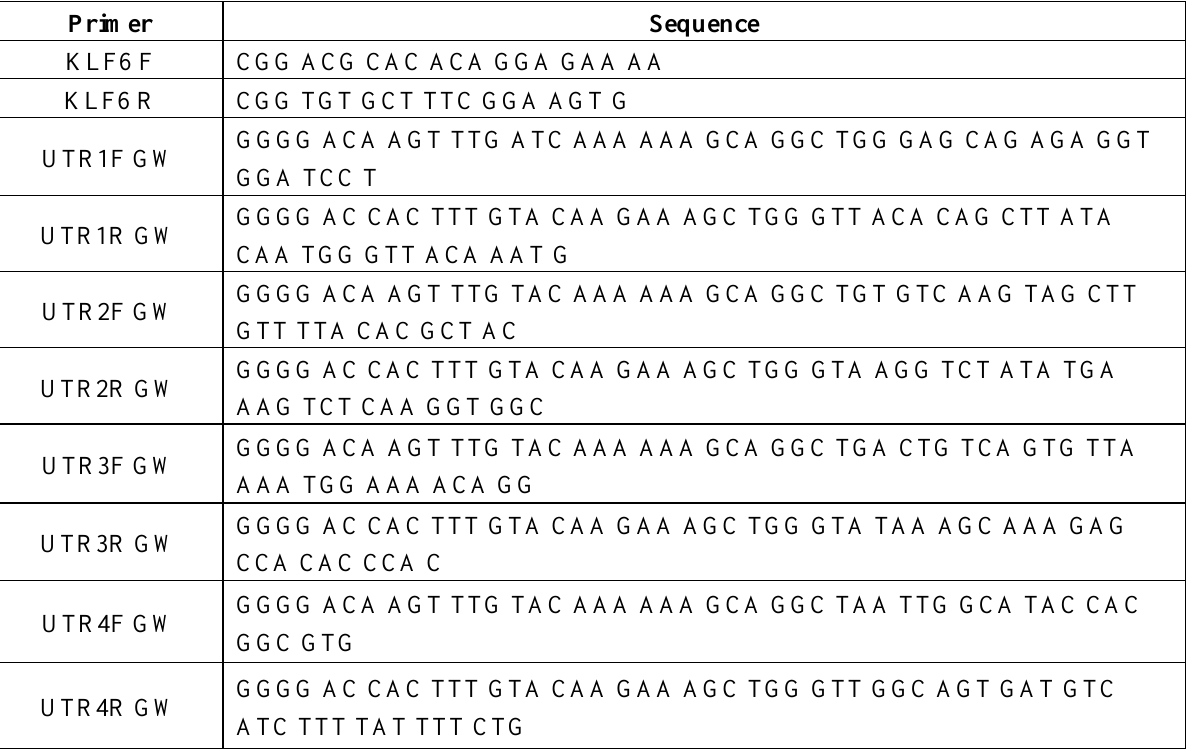
Table 1. Primer sequences used for PCR